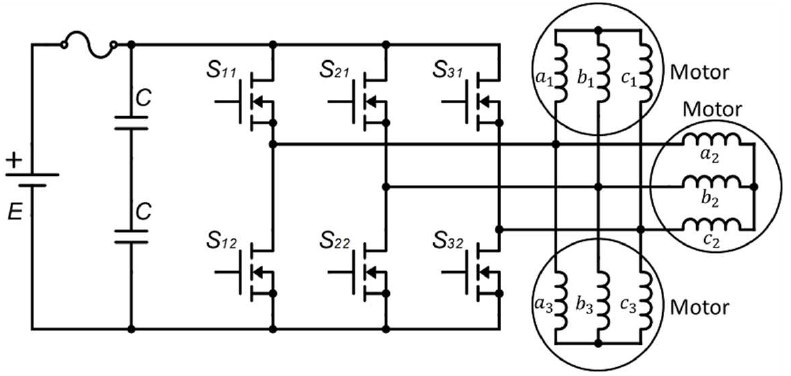
Figure 5. PCM topology for three-motor system [35].